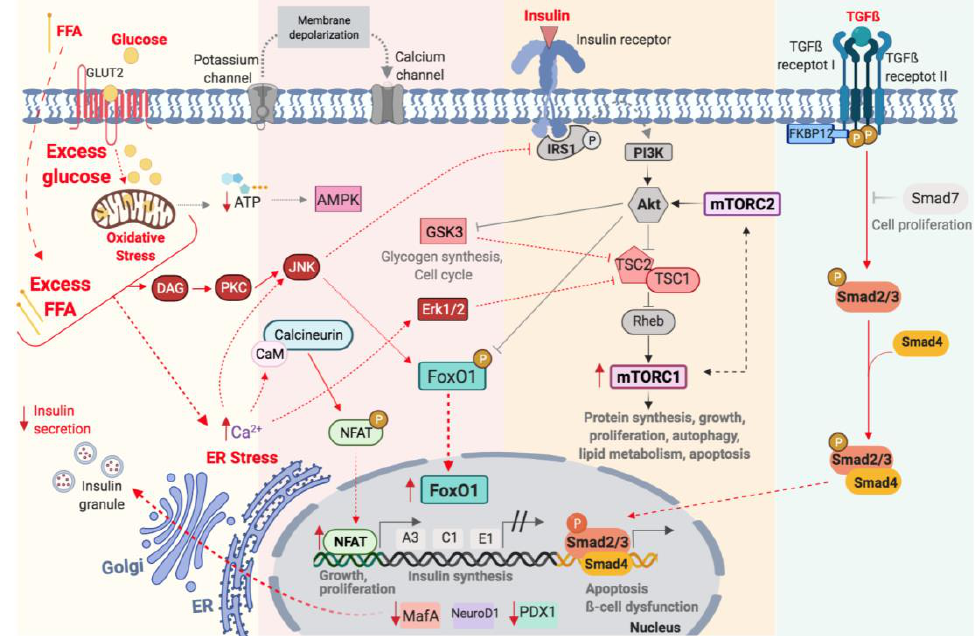
Figure 2. Schematic illustration of the activation of molecular pathway by glucolipotoxicity on pancreatic β–cell. pancreatic β